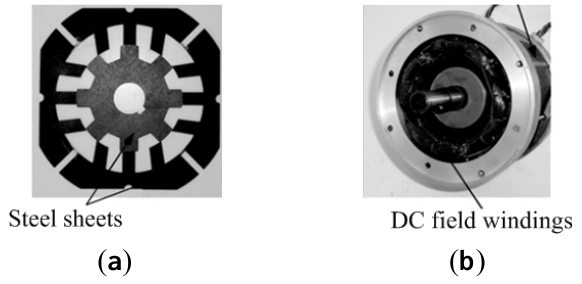
Figure 7. Hybrid-excitation DSPM motor (HEDS) ( a ) Steel sheets; ( b ) Assembly of the HEDS.